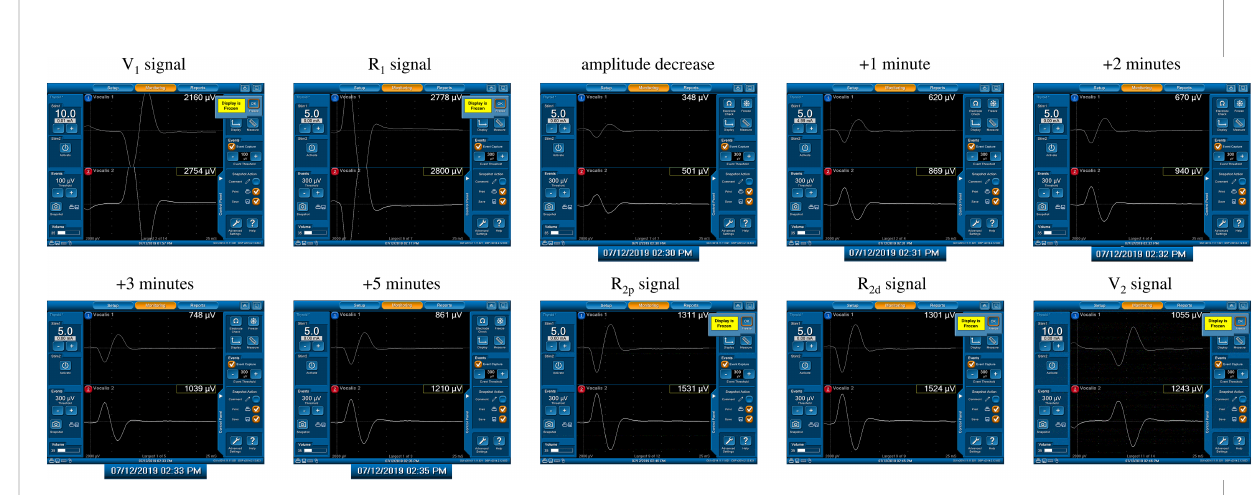
FIGURE 3 A signi fi cant amplitude decrease (channel 2) from 2800 µV (R1 signal) to 501 µV was detected. The actual operation time of the neuromonitoring screenshots is magni fi ed and displayed below, according to amplitude decrease, +1, +2, +3, +5 minutes after amplitude decrease, respectively. Gradual and progressive amplitude recovery was found within a few minutes after releasing thyroid traction. The amplitudes between the R 2p and R 2d signals showed no difference, but there was a 66% amplitude decrease between the R 2p and R 1 signals. This is a case of a Type C recovery pattern after traction injury.